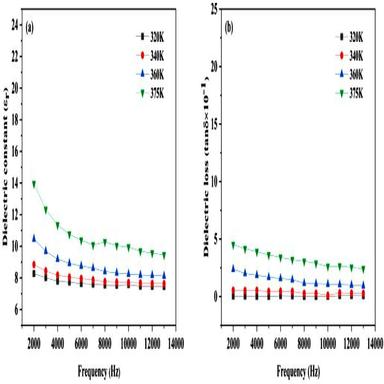
(a) Plot of dielectric constant at different temperatures. (b) Plot of dielectric loss at different temperatures.